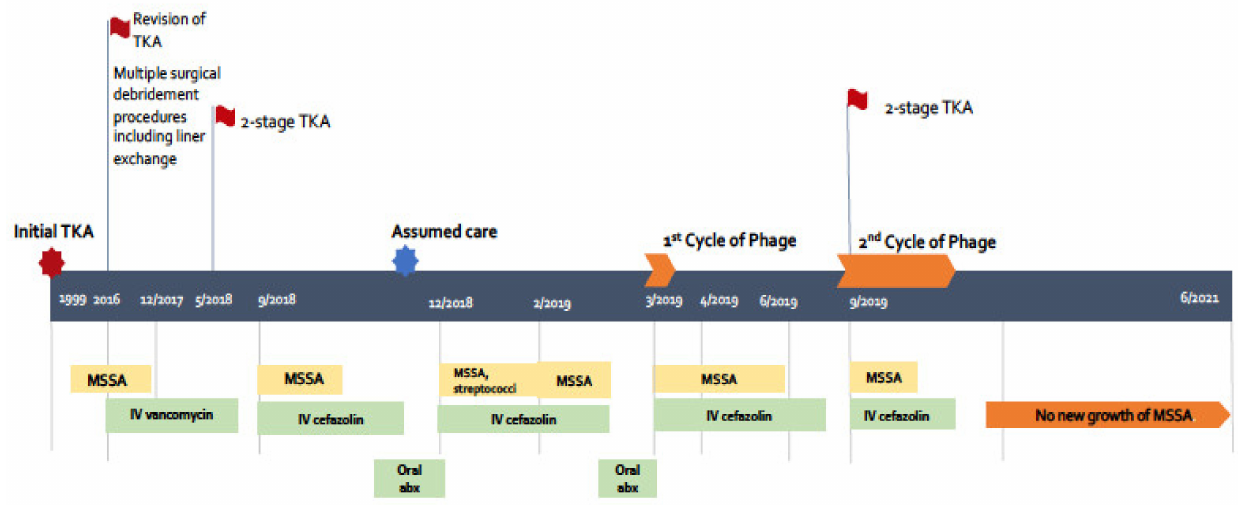
Figure 1. Timeline schematic of patient’s care (not to scale). TKA: total knee arthroplasty, MSSA: methicillin sensitive Staphylococcus aureus , IV: intravenous, abx: